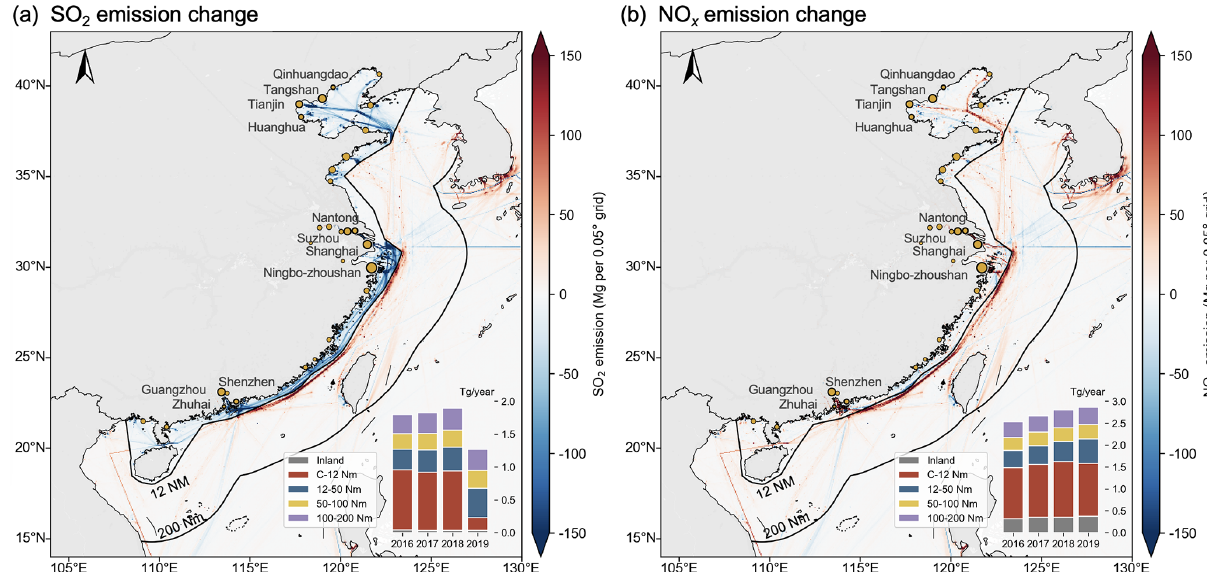
Figure 11. Spatial distribution changes in SO 2 and NO x emissions from ships in China in 2019 compared to 2016. The stacked bar plots indicate the annual emissions occurred at different distances off the coastline from 2016 to 2019. The “C-12Nm” in the legend refers to the area from the coastline to 12Nm from the baseline of the territorial sea (the same below), which is approximately equal to the scope of DECA 2.0.